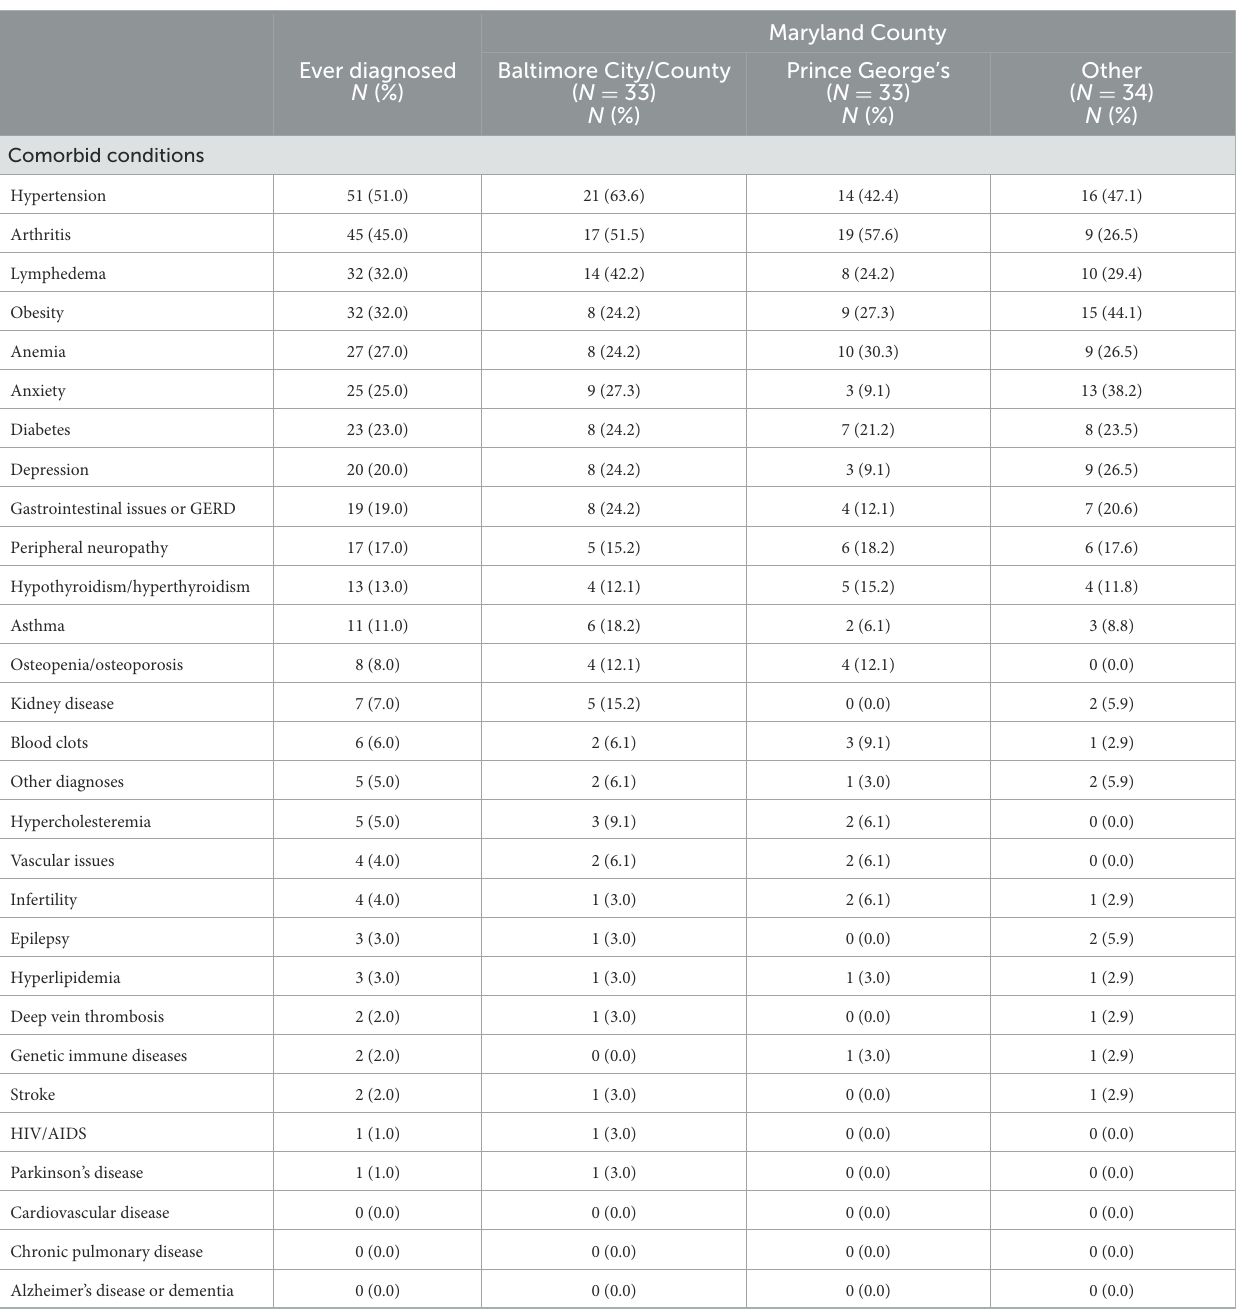
TABLE 3 Comorbid conditions reported by study participants overall and by Maryland